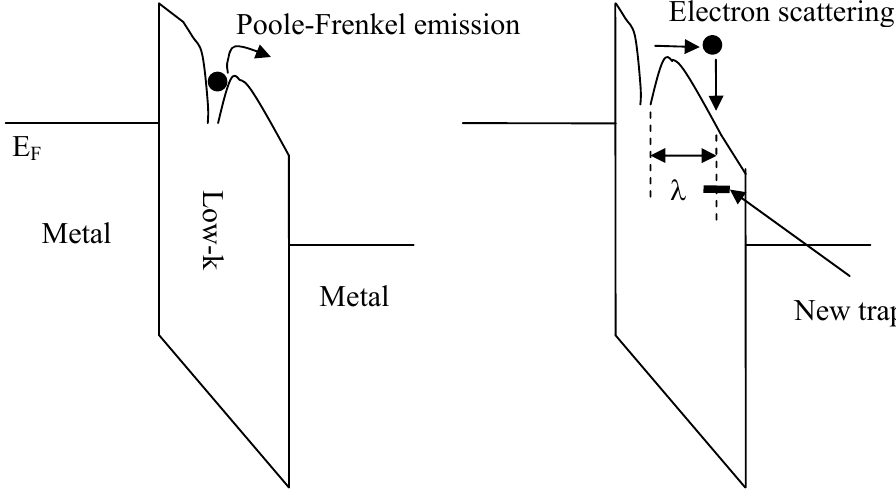
Figure 2. Energy band diagram, illustrating the defect generation process due to inelastic scattering of energetic electrons in Lloyd’s